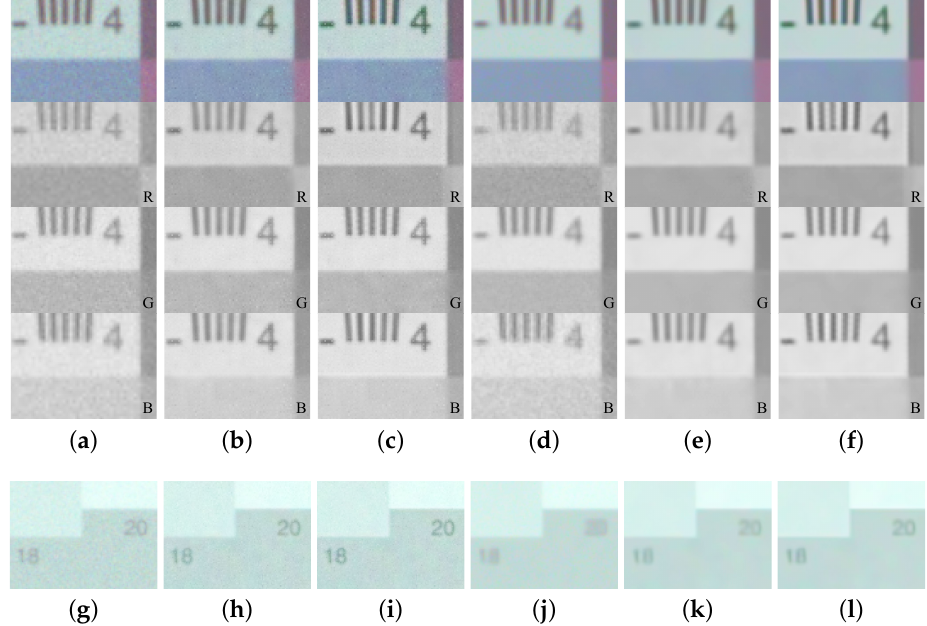
Figure 8. Experimental results with 5 lux low-light condition: ( a ) The demosaiced image using the Bayer pattern CFA with RI [10], ( b ) The demosaiced image using the Canon-RGBW CFA with modified RI [10], ( c ) The demosaiced image using the Canon-RGBW CFA with proposed method, ( d – f ) The results applying BM3D on ( a – c ). ( g – l ) use the same methods as ( a – f